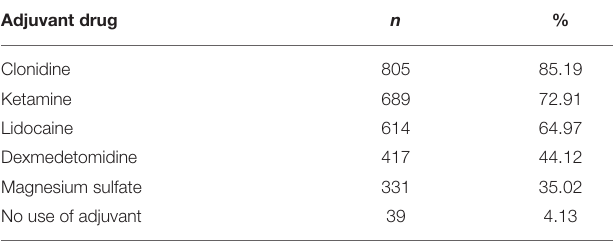
TABLE 2 | Frequency of use of adjuvant drugs in anesthesia ( n , %). Adjuvant drug n